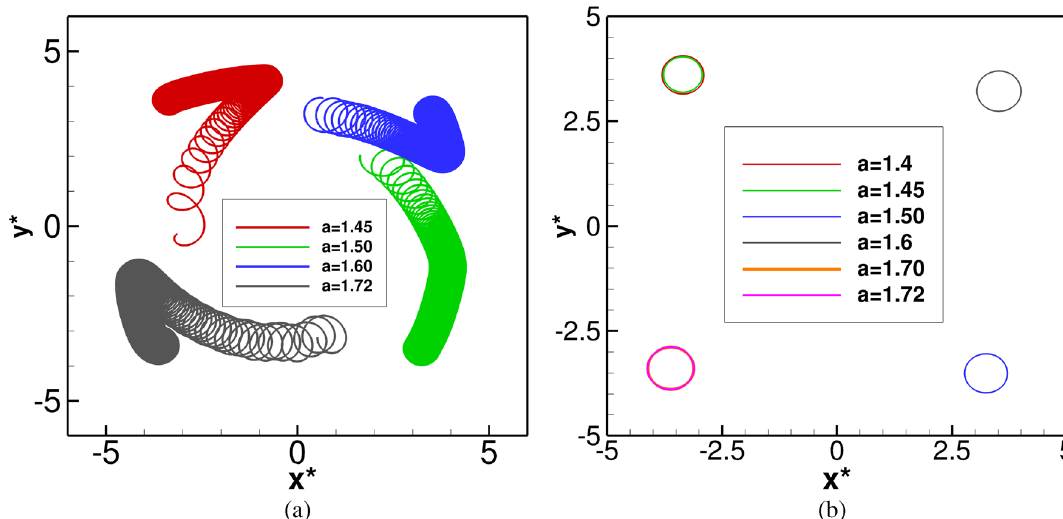
Figure 6. Dynamics of spiral wave in the presence of a circular obstacle: ( a ) tip trajectories for a = 1.45, 1.50, 1.60 and 1.72 in the time range 110.000 ≤ t ≤ 1500.00 , and ( b ) displaced core regions of the spiral waves for different values of parameter a .